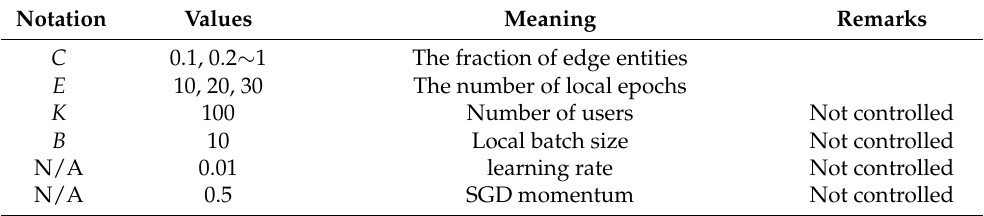
Table 1. Parameters used in our